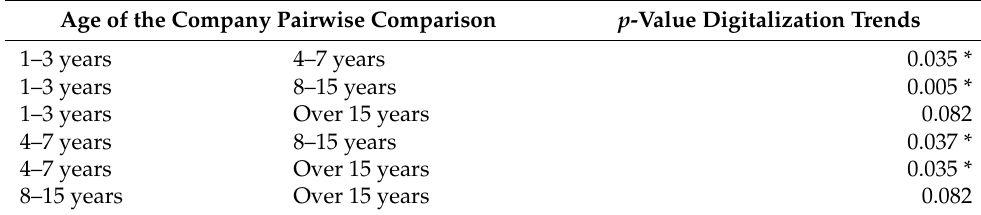
Table 11. Pairwise comparison using Mood’s median test: innovative solutions in logistics, digitaliza- tion trends vs. age of the